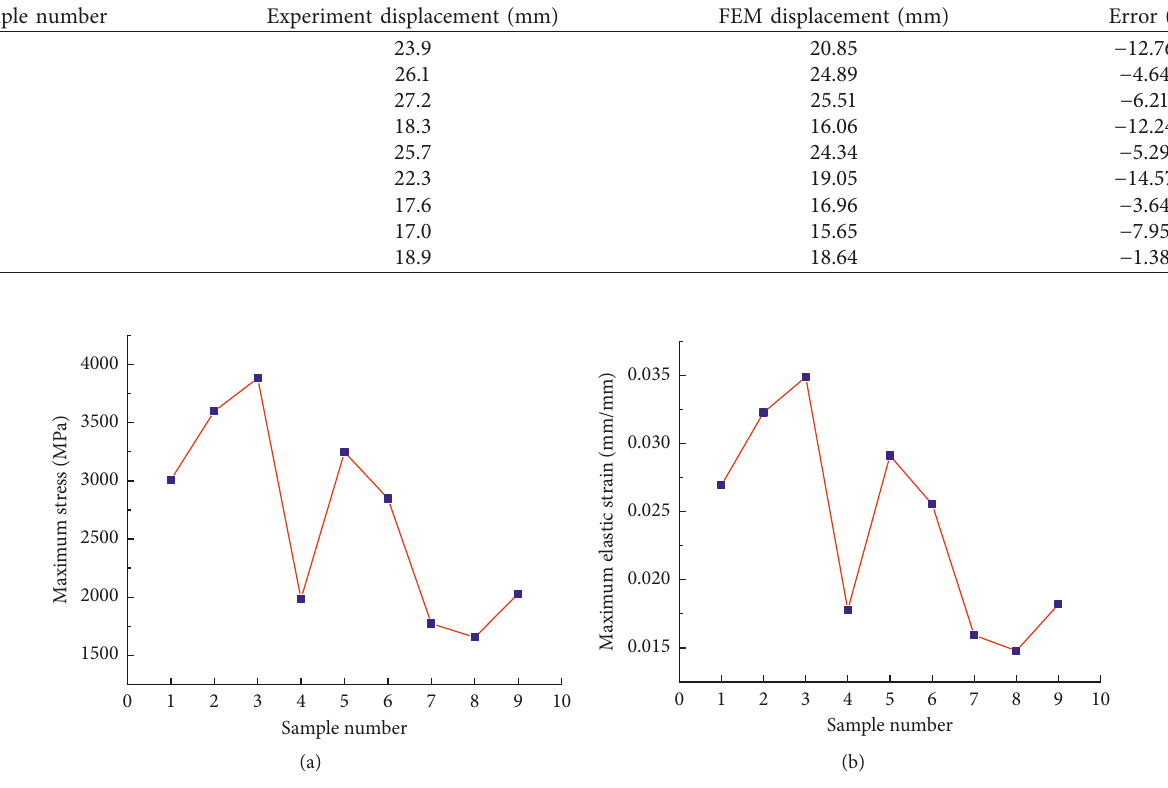
Figure 17: Simulated low-speed impact results. (a) Maximum stress and (b) strain in all specimens.